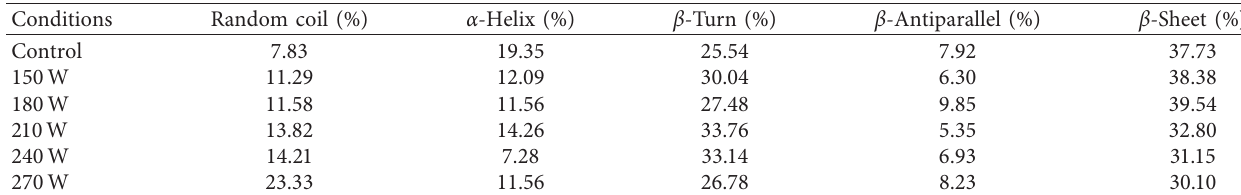
Figure 9: Microstructures of potato slices pretreated with different ultrasonic power values: (a) 0 (control), (b) 150, (c) 180, (d) 210, (e) 240, and (f) 270 W. Table 4: Calculation results of protein secondary